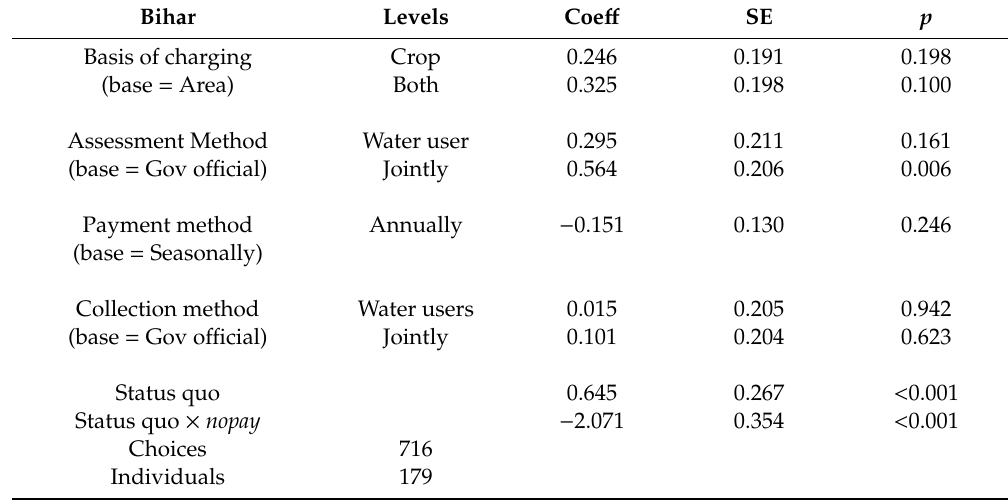
Table 6. Conditional logit estimates for preferences for irrigation payment systems: Bihar.